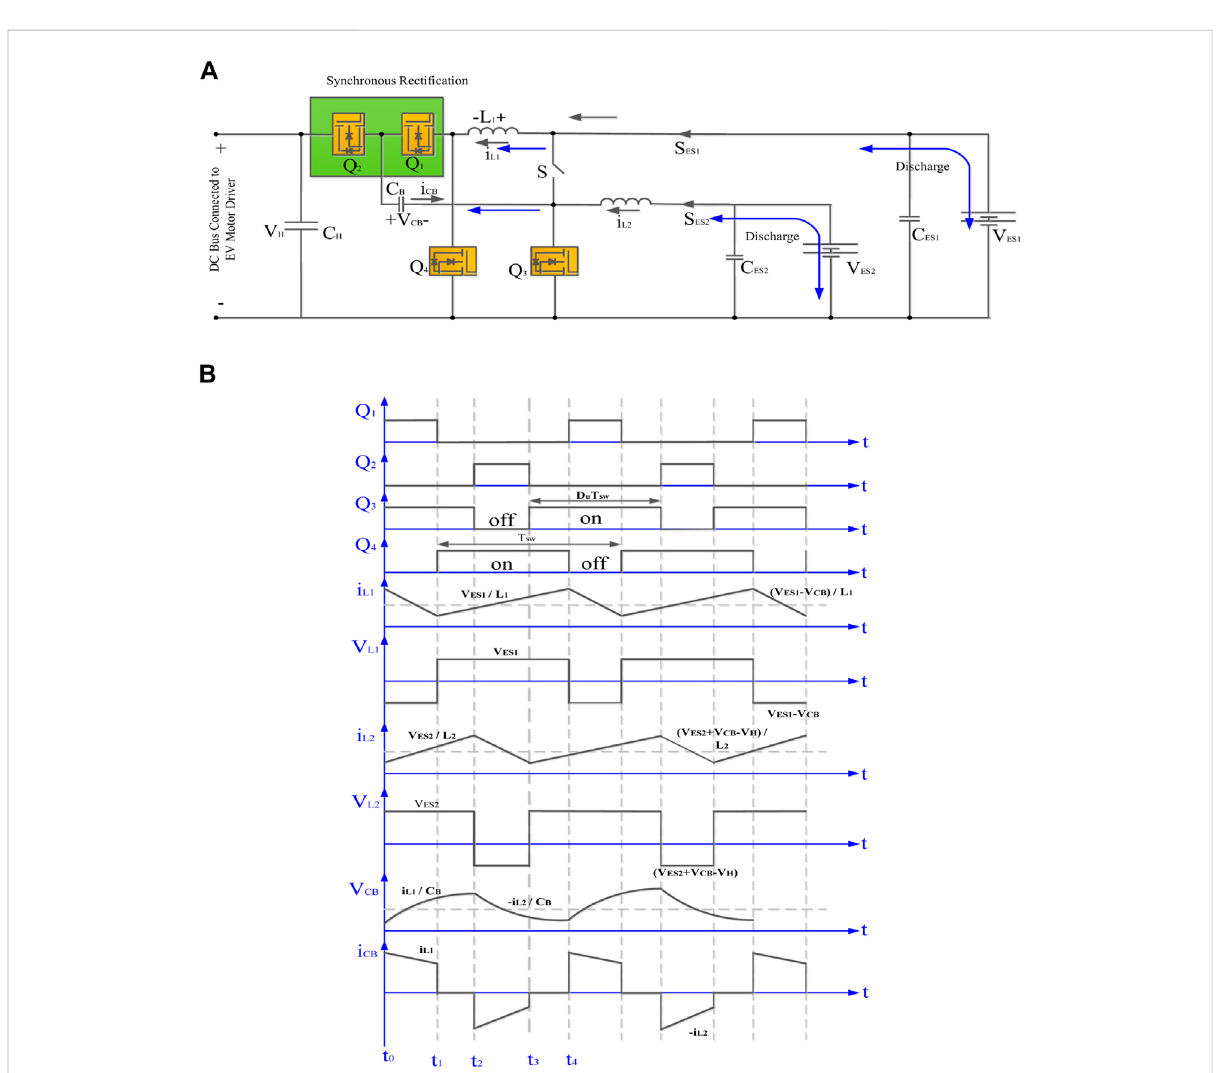
FIGURE 3 The proposed BDCC ’ s dual-source low-voltage powering mode: (A) Circuit design (B) Stable